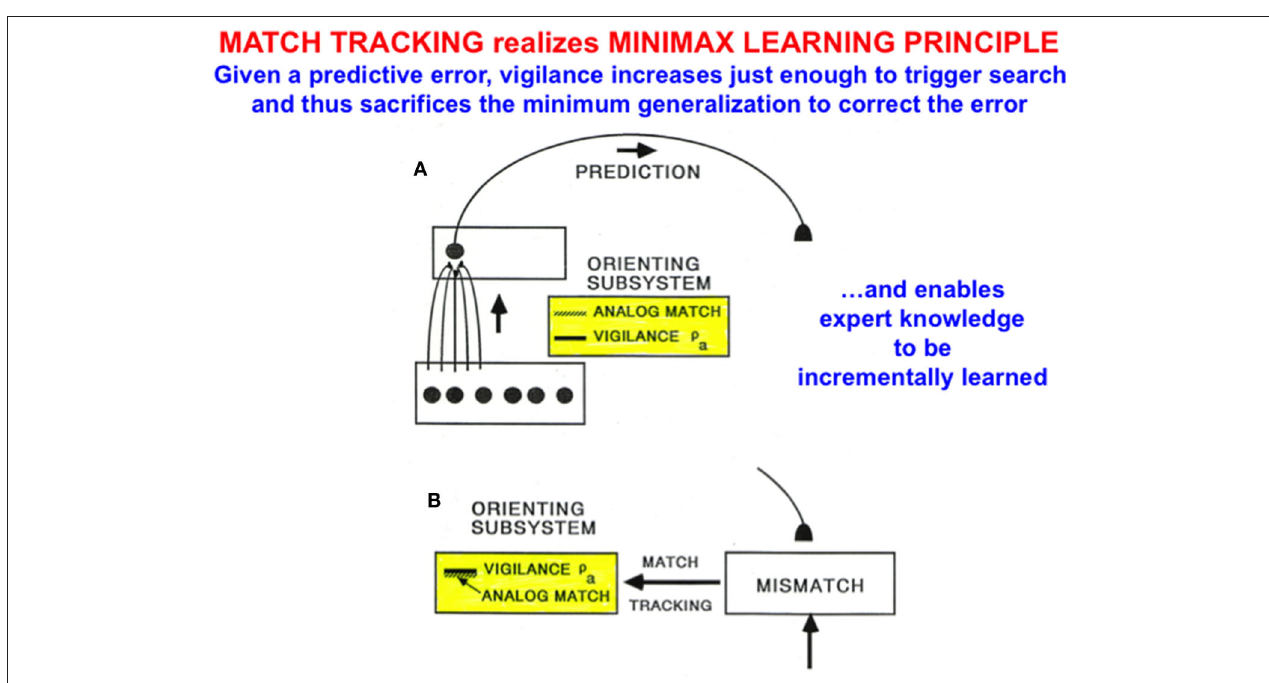
FIGURE 9 | (A) A prediction from ART a to ART b can be made if the analog match between bottom-up and top-down patterns exceeds the current vigilance value. (B) If a mismatch occurs between the prediction at ART b and the correct output pattern, then a match tracking signal can increase vigilance just enough to drive hypothesis testing and memory search for a better-matching category at ART a . Matching tracking hereby sacrifices the minimum amount of generalization necessary to correct the predictive error [adapted with permission from Carpenter and Grossberg (1992)].